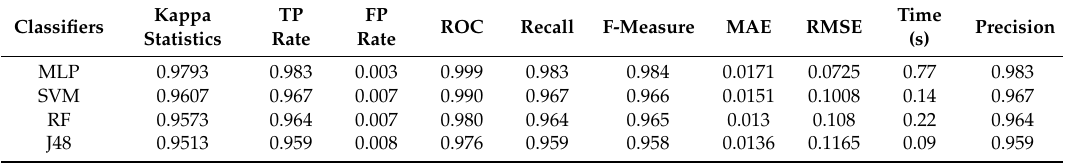
Table 7. The overall classification accuracy results using Radiopaedia dataset using ML classifiers.